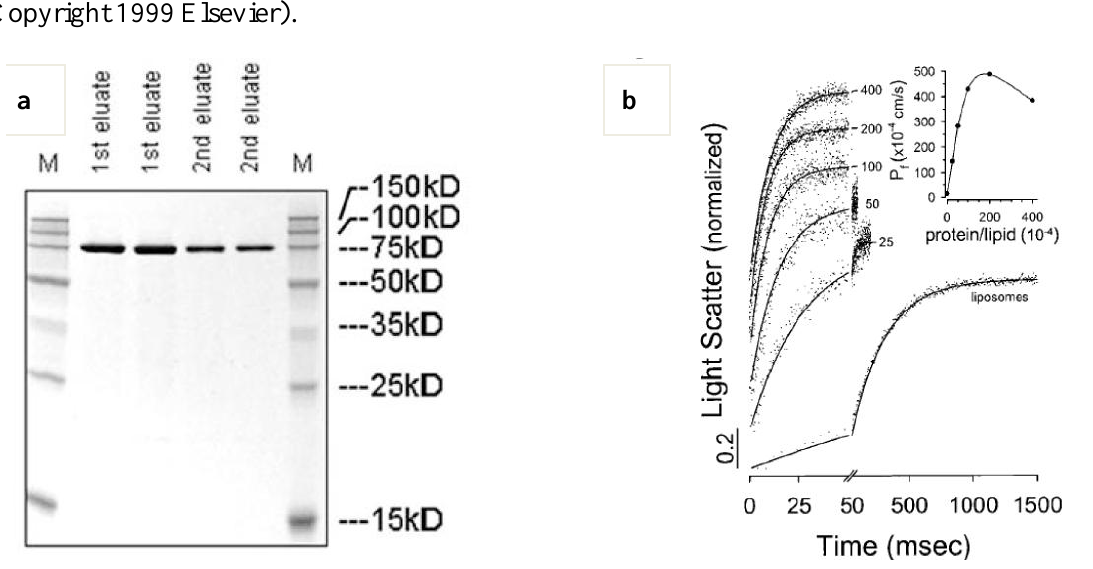
Figure 7. Aquaporin Z-incorporated vesicles. ( a ) Sodium dodecyl sulfate-polyacrylamide gel electrophoresis (SDS-PAGE) of purified aquaporin Z (M: marker) and ( b ) stopped-flow light scattering and osmotic water permeability coefficient of aquaporin Z-incorporated liposomes in response to hyperosmotic stress (reprinted with permission from